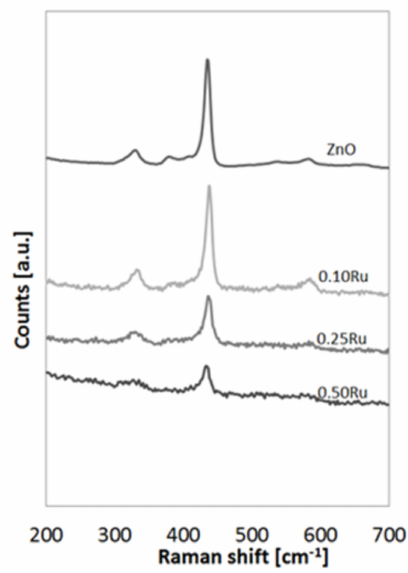
Figure 2. Raman spectra of the undoped and Ru-modified ZnO in the range 200–700 cm − 1 .